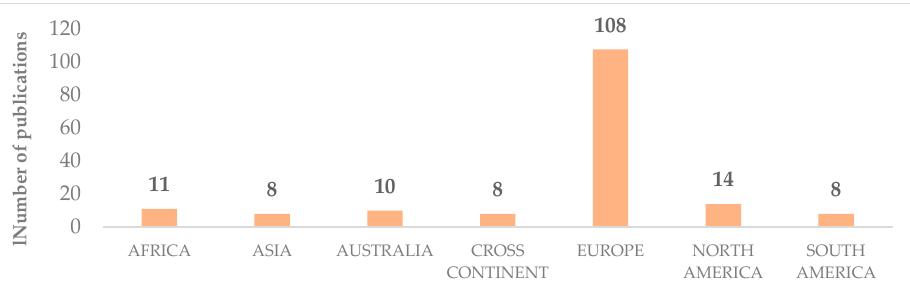
Figure 3. Distributions of articles per year of publication. Regarding the sources, a total of 34 different journals were counted. Among these, only 8 journals counted for more than 2 publications. The journal that accounted for the largest number of publications is Food Quality and Preference (20 publications), followed by Journal of Insects as Food and Feed (10 publications), British Food Journal (9 publica- tions), Foods (9 publications), Insects (6 publications), Appetite (4 publications), Food Re- search International (4 publications), and Sustainability (3 publications).